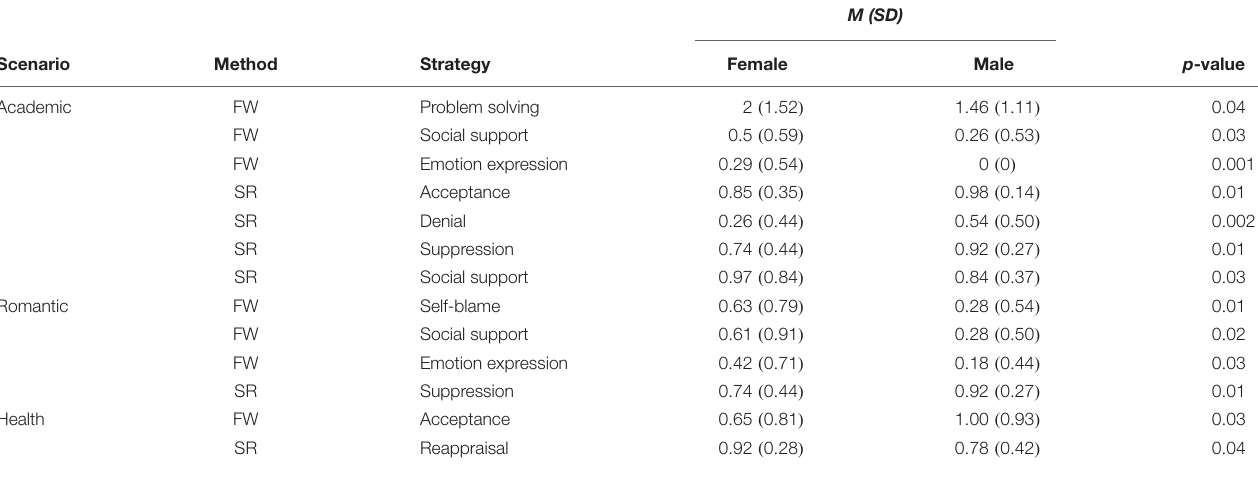
TABLE 4 | Means and standard deviations for gender differences in individual strategy use within each